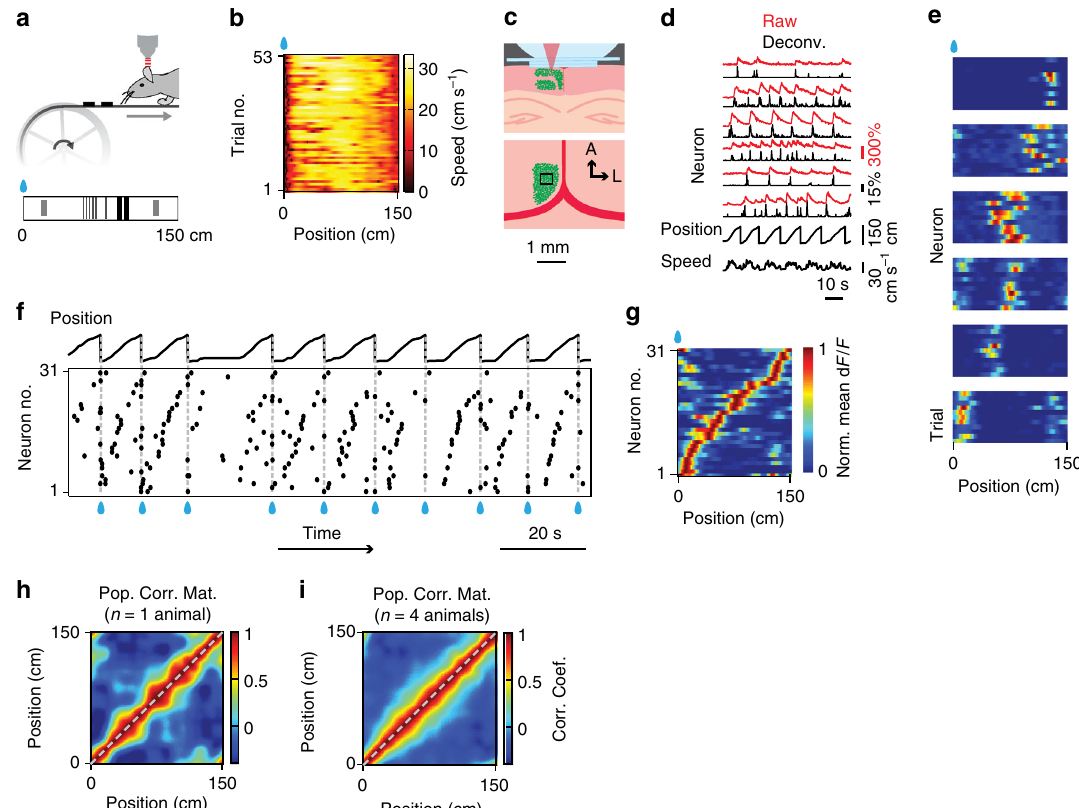
Fig. 1 Sparse orthogonal population representation of spatial location in the retrosplenial cortex. a Head- fi xed locomotion assay. Mice moved a 150-cm linear treadmill ( top ) with tactile cues on its surface ( bottom ). A drop of sucrose water ( blue ) was delivered at a fi xed location for every completed lap. b Lap running behaviour. Movement speed as a function of location for 53 consecutive laps from one experimental session. The animal moved robustly and slowed down or paused most frequently near the reward (as shown by dark colours on the left ). c Cellular imaging of neural activity in the retrosplenial cortex (RSC) during head- fi xed treadmill running. ( top ) Illustration of super fi cial and deep RSC neurons labelled with calcium indicator GCaMP6m (green dots). Calcium imaging was performed with a two-photon microscope through a glass window. ( bottom ) Tangential view of the labelled super fi cial RSC neurons with an example imaging fi eld of view ( black square ). Red lines indicate superior sagittal sinus and transverse sinuses. Scale bar, 1 mm. A: anterior; L: lateral. d Calcium fl uorescence signals ( top , red ) and inferred neural activity ( top , black ) of six example super fi cial agranular RSC neurons showing place cell activity; speed and treadmill position are at the bottom. Neural activity was inferred using a fast non-negative deconvolution algorithm 64. e Normalized activity of the six RSC place cells in d as a function of location for multiple laps. The y axis in each colour map corresponds to trial number. Note how neurons were activated as the animal crossed speci fi c locations. Activity was normalized to the time spent at individual locations. f Raster plot showing activation time points for 31 simultaneously imaged RSC place cells, for the same session as in e , together with position ( top ). Activation time points de fi ned as time points of peak response in each lap for each neuron. Cells ordered by the location that evoked largest responses. Note the repeated sequences of activation during movement and lack of activation when the animal was not moving. g Average normalized activity as a function of location for the 31 RSC place cells shown in f . h Correlation matrix (Pearson correlation coef fi cient) of population vectors as a function of position for data shown in g . i Correlation matrix (Pearson correlation coef fi cient) of population vectors as a function of position for data from four mice. (Data from WT mice with AAV1-hSyn-GCaMP6m